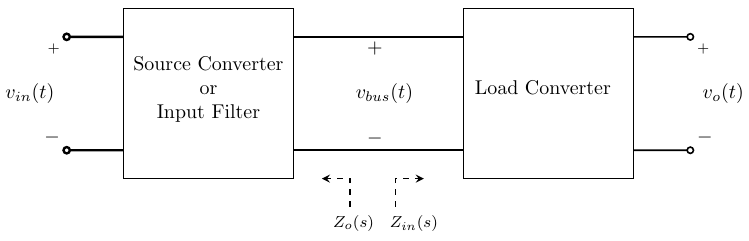
Figure 1. A typical cascaded system configuration illustrating the source output impedance ( Z o ) and the load input impedance ( Z in